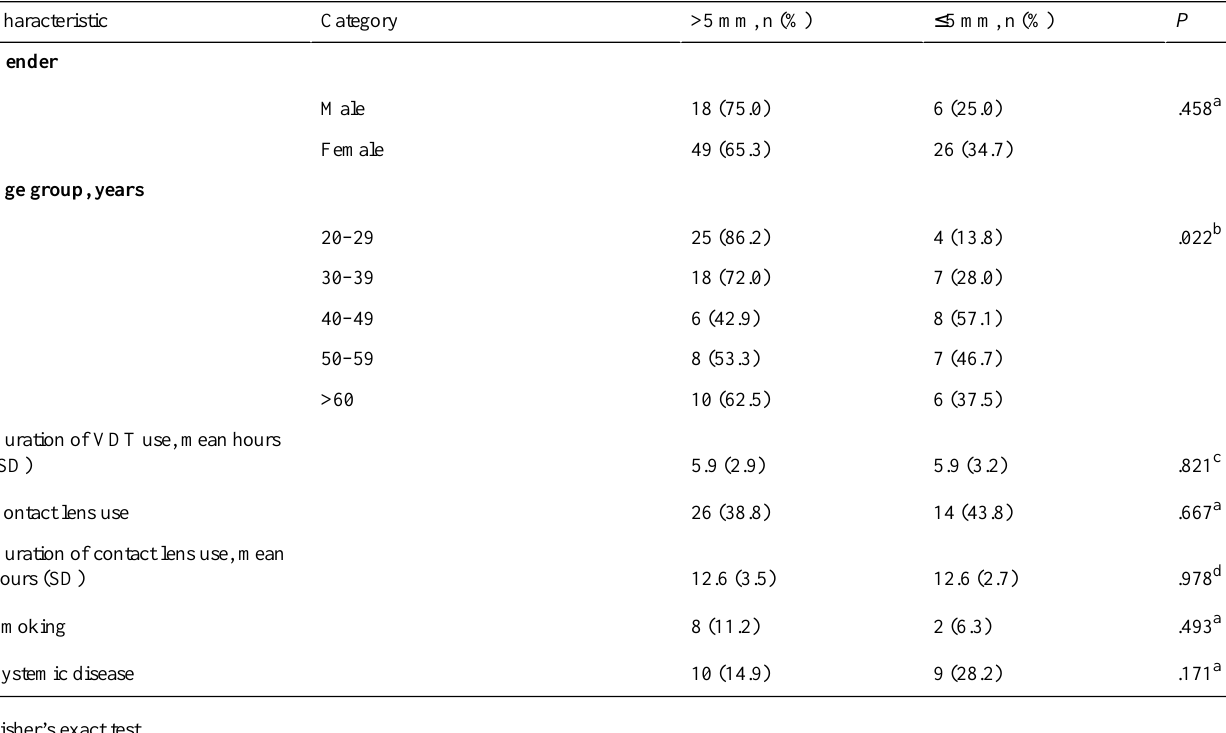
Table 4. Comparison of the groups with >5 mm (normal) and ≤ 5 mm (abnormal) tear